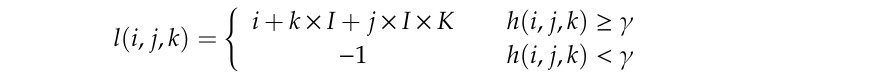
Figure 4. Peaks searched from a 3D flag map. Using Equation (1), the peaks’ coordinates ( i , j , k ) in the Hough space ( θ , φ , r ) are transformed to targeting plane parameters in a Cartesian coordinate system using Equation (1), as the inverse process.